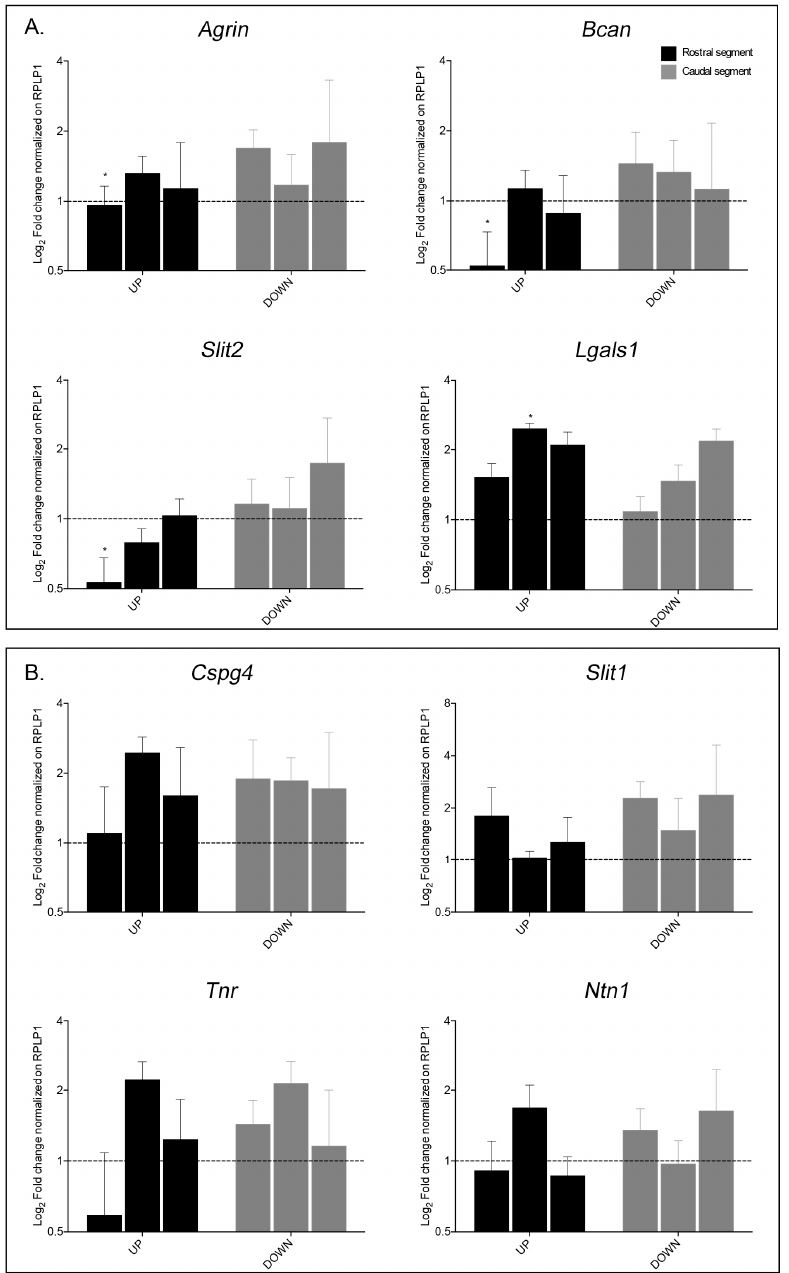
Figure 4. Time-course changes in mRNA expression level for neural extracellular matrix encoding genes: ( A ) Genes presenting a statistically significant difference in expression level; ( B ) Genes presenting non-significant variation. Real Time – Polymerase Chain Reaction (RT-PCR) data is represented as Log2 fold change of gene expression normalized on the respective intact segment of spinal cord, shown by the dotted line ( n = 4 animals per group per time point). The black bars show the results obtained from the rostral segment, whereas the gray bars show the segment caudal to the lesion. Statistical analysis: one-way ANOVA with Fisher’s LSD, Agrin p = 0.041, t = 2.146 (4, 27); Bcan p = 0.0441, t = 2.112 (5, 27); Slit2 p = 0.0341, t = 2.232 (5, 27); Lgals1 p = 0.035, t = 2.22 (4, 27), * p < 0.05.